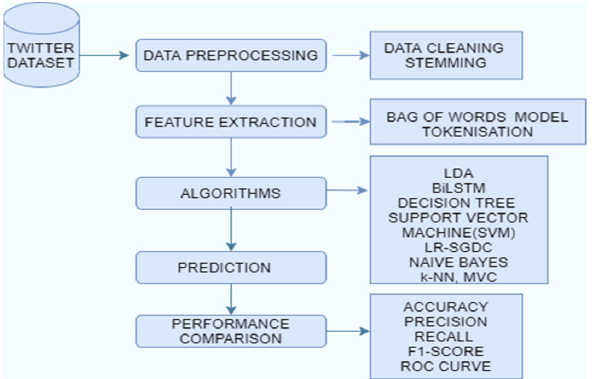
Figure 1. Workflow of COVID-19 sentiment analysis.